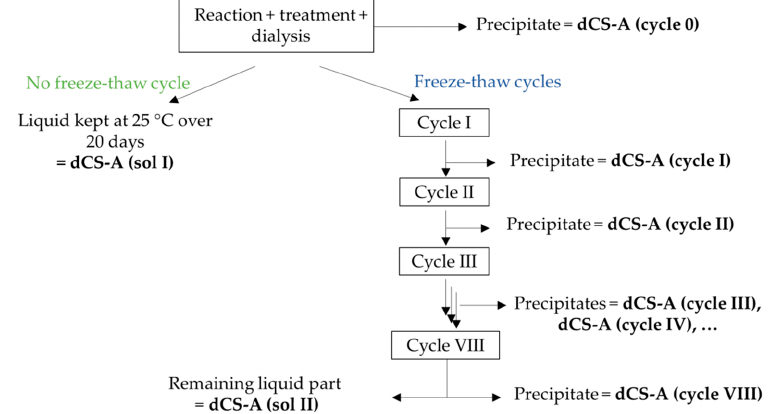
Figure 2. Diagram of the freeze–thaw cycles protocol. Names of the samples as reported in Table 4 are indicated in bold.